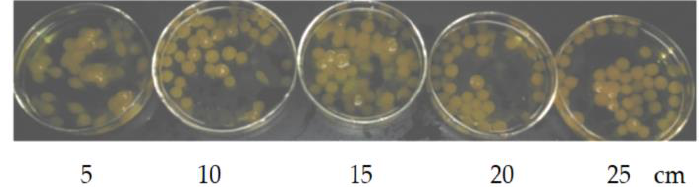
Figure 2. Effects of drop height on the “boba” ball.